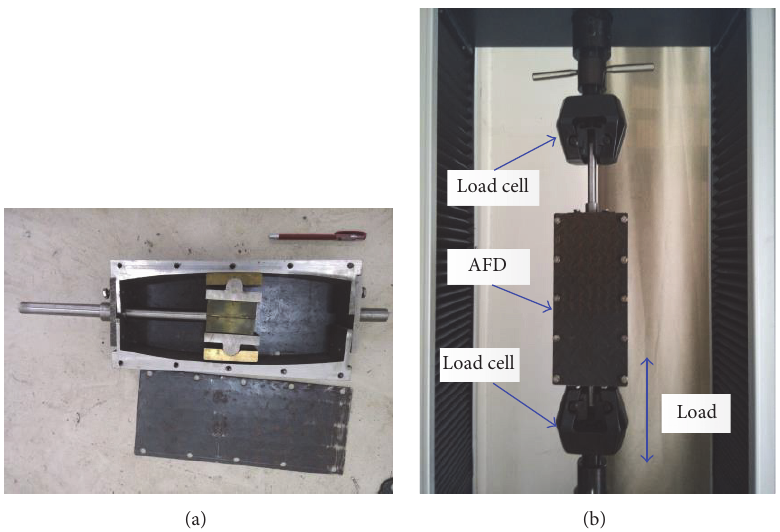
Figure 2: Test setup: (a) main parts of AFD and (b) test frame.